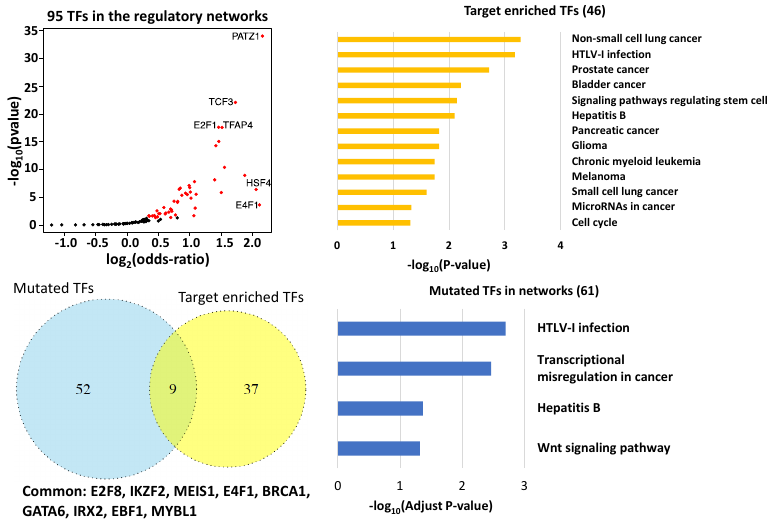
Figure 2. Key transcription factors in the network. ( a ) A total of 95 TFs demonstrated significant expression level alterations in lung adenocarcinomas and had at least one target gene in the same network. ( b ) The pathways that were significantly enriched for the 46 key TFs. ( c ) Nine common TFs were revealed by overlapping 46 key TFs with 61 TFs carrying at least one somatic